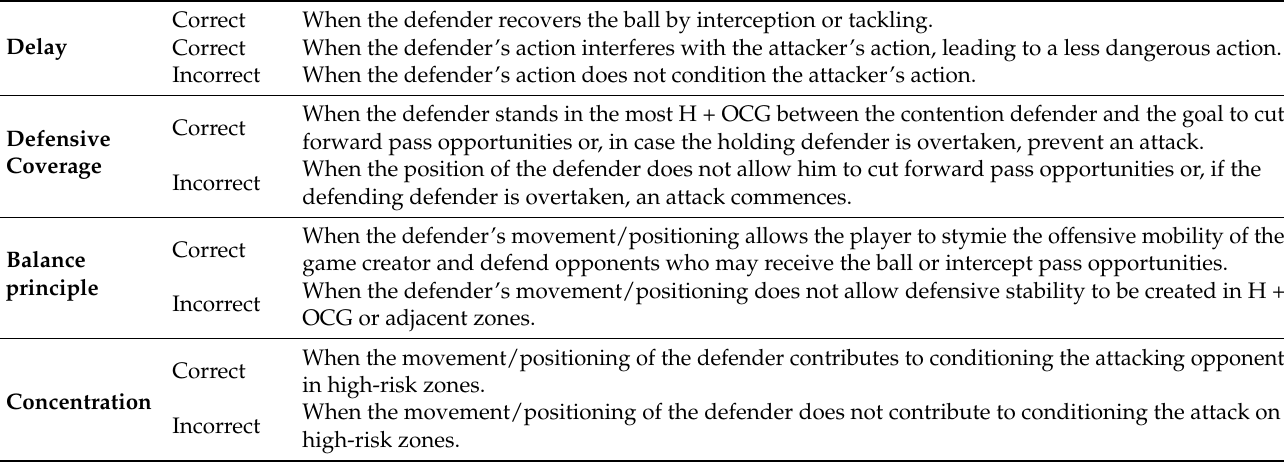
Table 5. Classification of motor effectiveness regarding performance indicators as correct and incorrect for specific defensive game